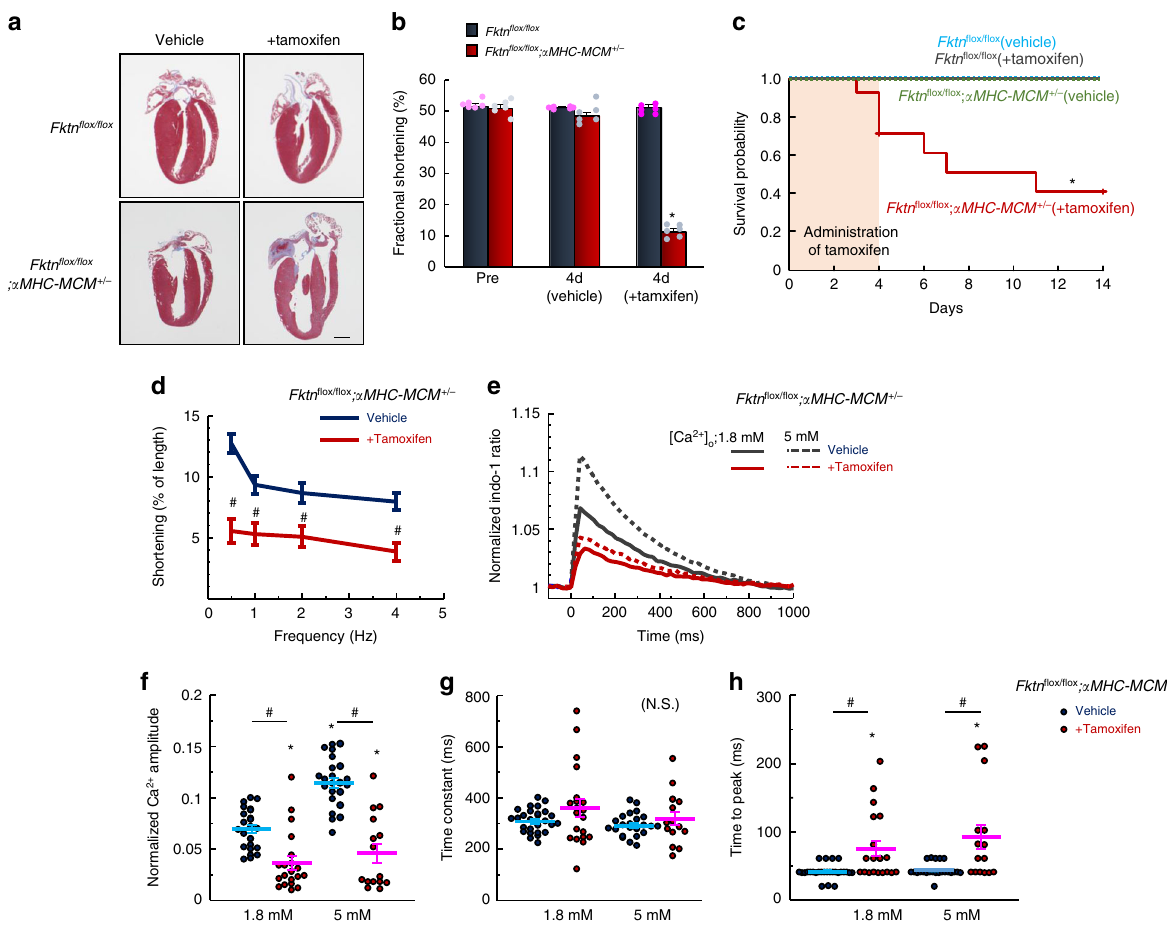
Fig. 6 Acute elimination of cardiac Fktn from 10-week-old mice. Cardiac morphology (scale bar, 1 mm) ( a ) and function ( n = 6 per group) ( b ) in control ( fl oxed) and α MHC-MCM- Fktn -cKO ( Fktn fl ox/ fl ox ; α MHC-MCM + / − ) mice after 4 d of tamoxifen treatment. * P < 0.05 vs. fl oxed mice before tamoxifen treatment based on Dunnett ’ s post-hoc tests. c Survival probabilities ( n = 14 per group). * P < 0.05 vs. vehicle-treated fl oxed mice based on log-rank tests. d Frequency-dependent shortening of myocytes isolated from mice treated with or without tamoxifen for 4 d ( n = 21 – 30 cells measured from 3 hearts per group). # P < 0.05 vs. vehicle-treated mice based on Student ’ s t -tests. e Indo-1 fl uorescence in single cardiomyocytes stimulated at 1 Hz (1.8 mM Ca 2 + , vehicle, n = 27 cells; + Tamoxifen, n = 20 isolated from 3 hearts per groups; 5 mM Ca 2 , vehicle, n = 23 cells; + Tamoxifen, n = 15 isolated from 3 hearts per group). Normalized peak amplitude ( f ), decay time constant (obtained by fi tting the decline phase) ( g ), and time to peak ( h ) of Ca 2 + transients. * P < 0.05 vs. myocytes from fl oxed mice at 1.8 mM Ca 2 + ; # P < 0.05 between indicated groups based on Tukey – Kramer